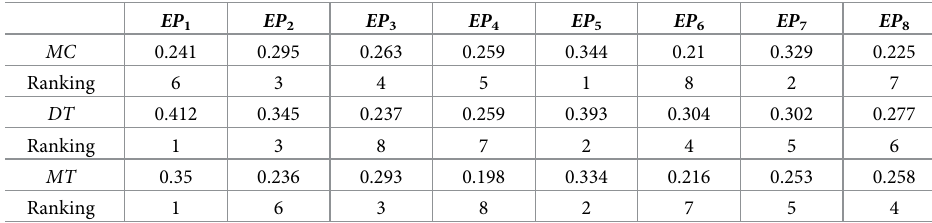
Table 13. The importance ranking of engineering property